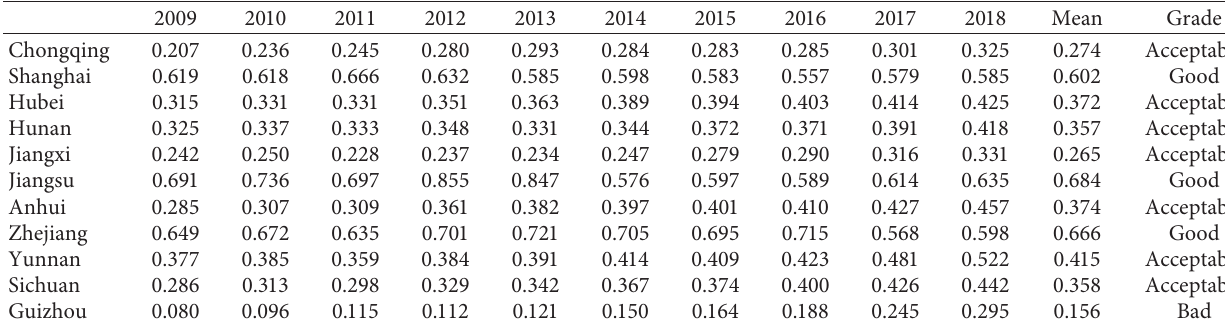
Table 5: DD of tourism